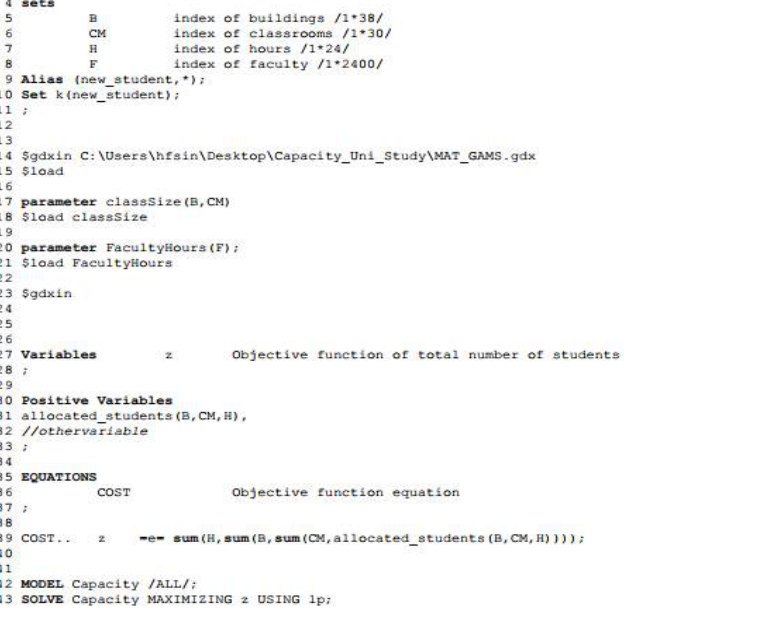
Figure 3. An excerpt of code used in GAMS to develop the top-down part of the planning framework. Table 2. Results of the top-down method, showing different capacities based on the number of operational hours.